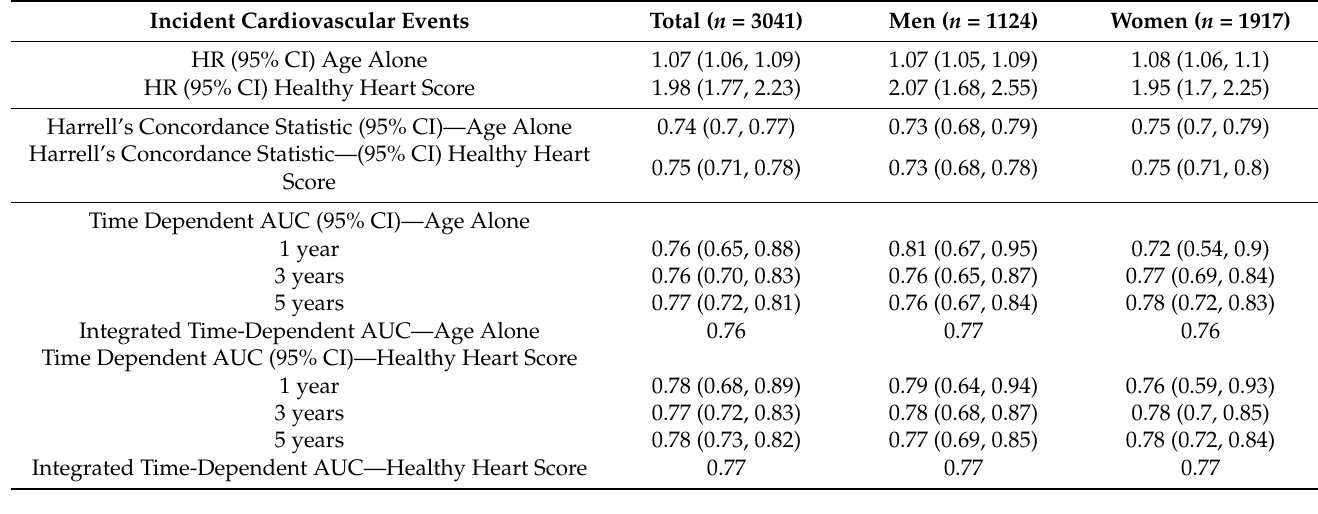
Table 2. Model performance of the Healthy Heart Score in the JHS for Cardiovascular Events in the overall cohort, men and women, (a) age only model; (b) Healthy Heart Score.